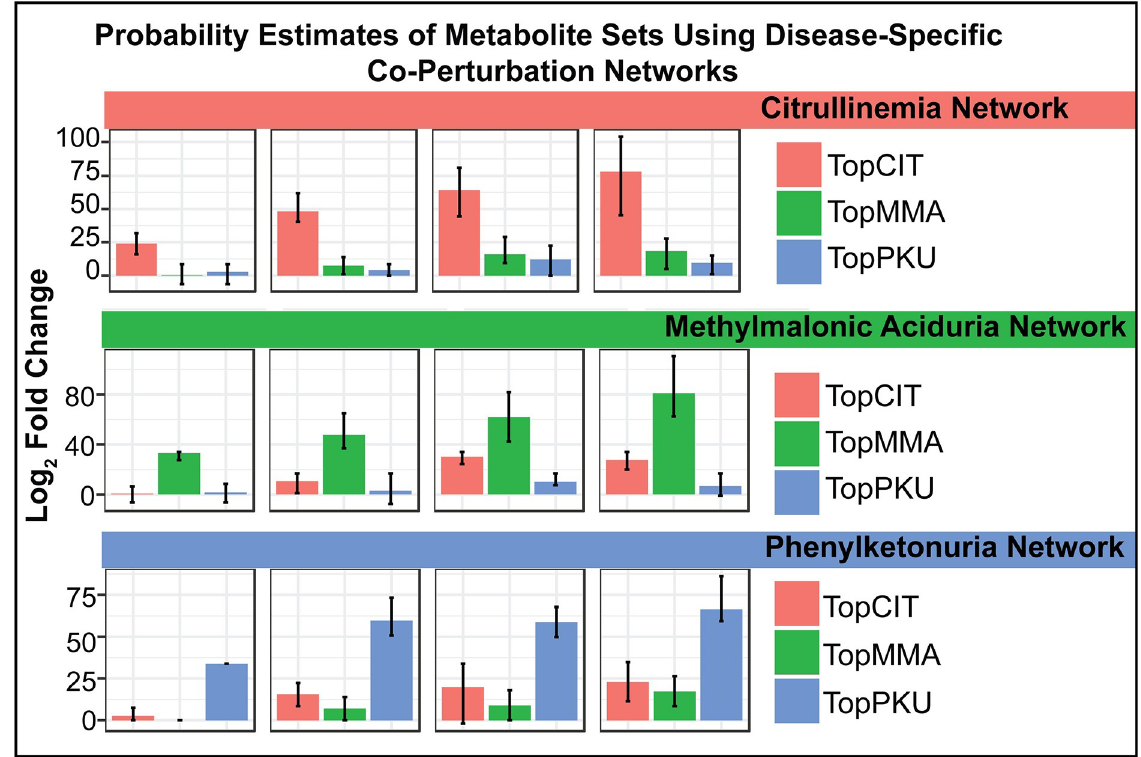
Fig 7. The probability of a metabolite set depends on the disease-specific network used in the encoding process. The probability of the 5, 10, 15 or 20 most perturbed metabolites across (A) citrullinemia samples (B) methymalonic aciduria samples or (C) phenylketonuria samples is much larger when using the network learned from patients with citrullinemia, methylmalonic aciduria, and phenylketonuria, respectively, compared to the probability of the same metabolite set when using a permuted network. Error bars indicate signal observed across several network folds when using a leave-one-out cross validation scheme for network learning and